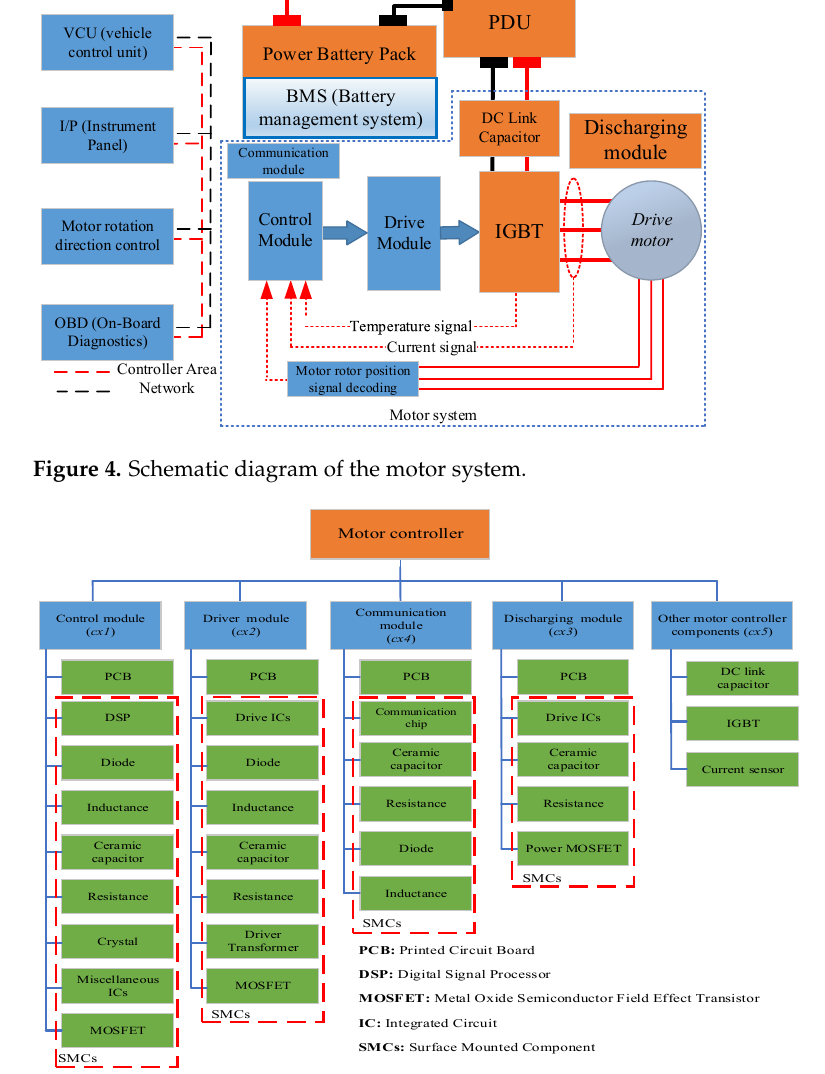
of the entire powertrain system is shown in Figure 6.